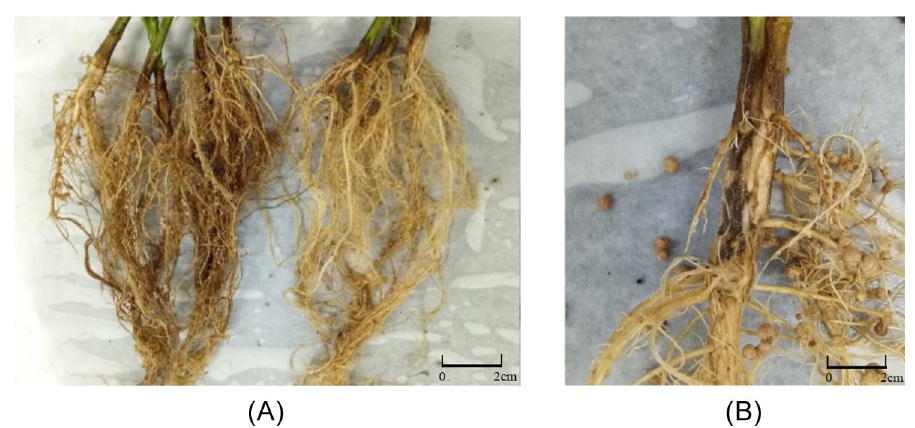
Fig 1. Soybean root rot. (A) The root system of plant inoculated with F . oxysporum shows roots of the group that was only inoculated with the pathogenic fungus F . oxysporum (left, F) and simultaneous inoculation of F . mosseae and the pathogenic fungus F . oxysporum (right, AF). (B) Prominent in the red frame is the disease spot of root system inoculated with F . oxysporum .